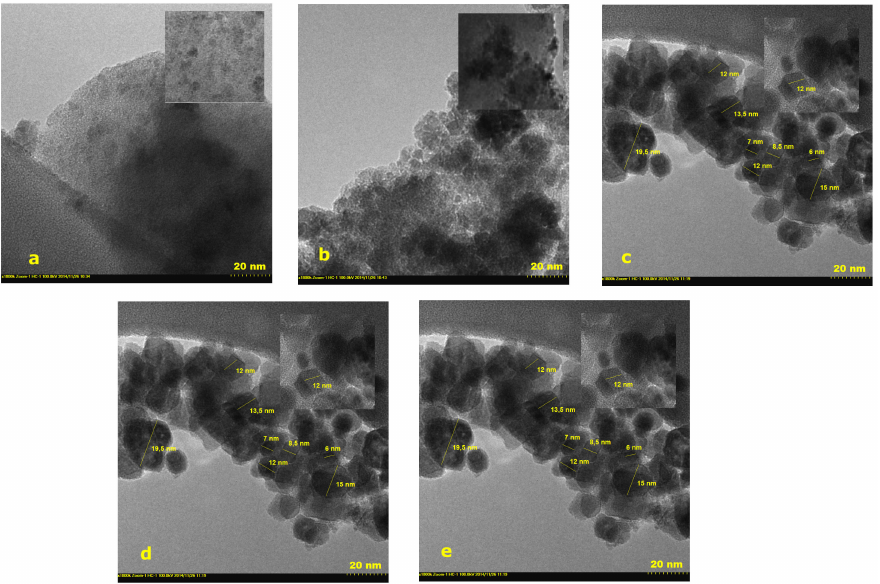
Figure 5. Transmission electron microscopy (TEM) recorded at di ff erent thermal treatment temperatures ( a ) 120 ◦ C, ( b ) 220 ◦ C, ( c ) 260 ◦ C, ( d ) 300 ◦ C, and ( e ) 400 ◦